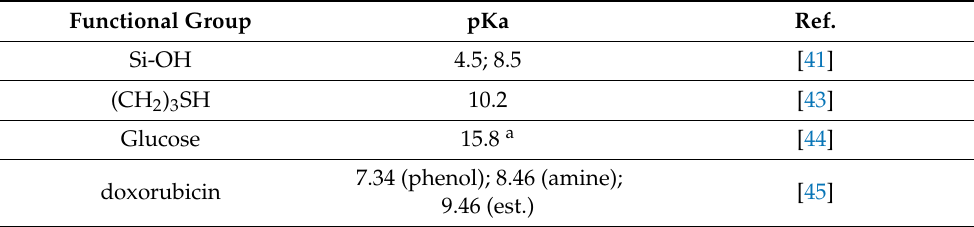
Table 2. pKa values of the system components, according to literature.